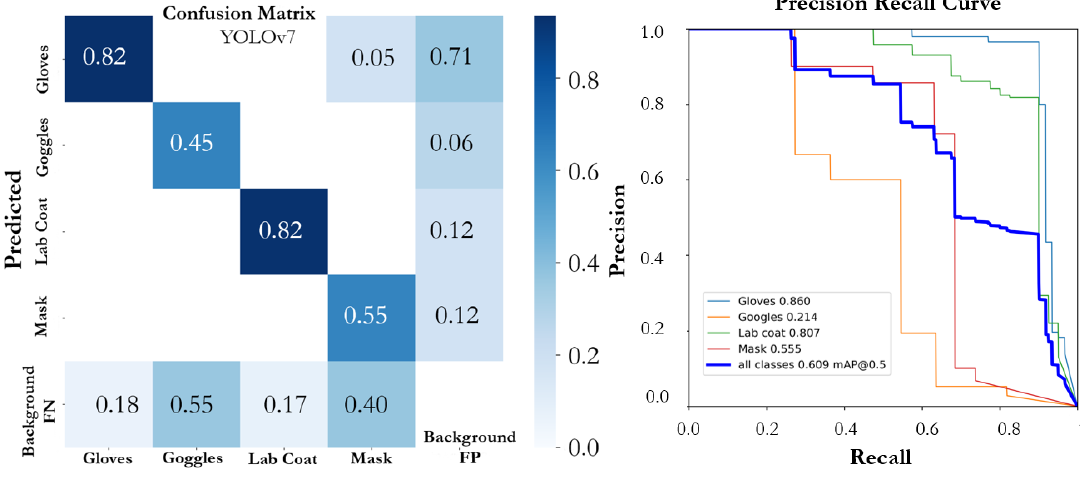
Figure 13. Confusion matrix and PR curve of the YOLOv7 model.